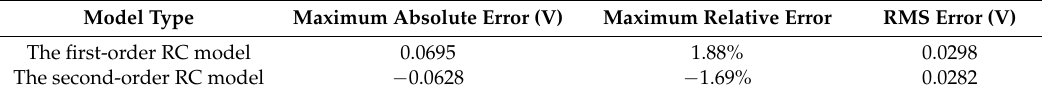
Table 5. The output error of the first-order and the second-order models for the UDDS cycle.